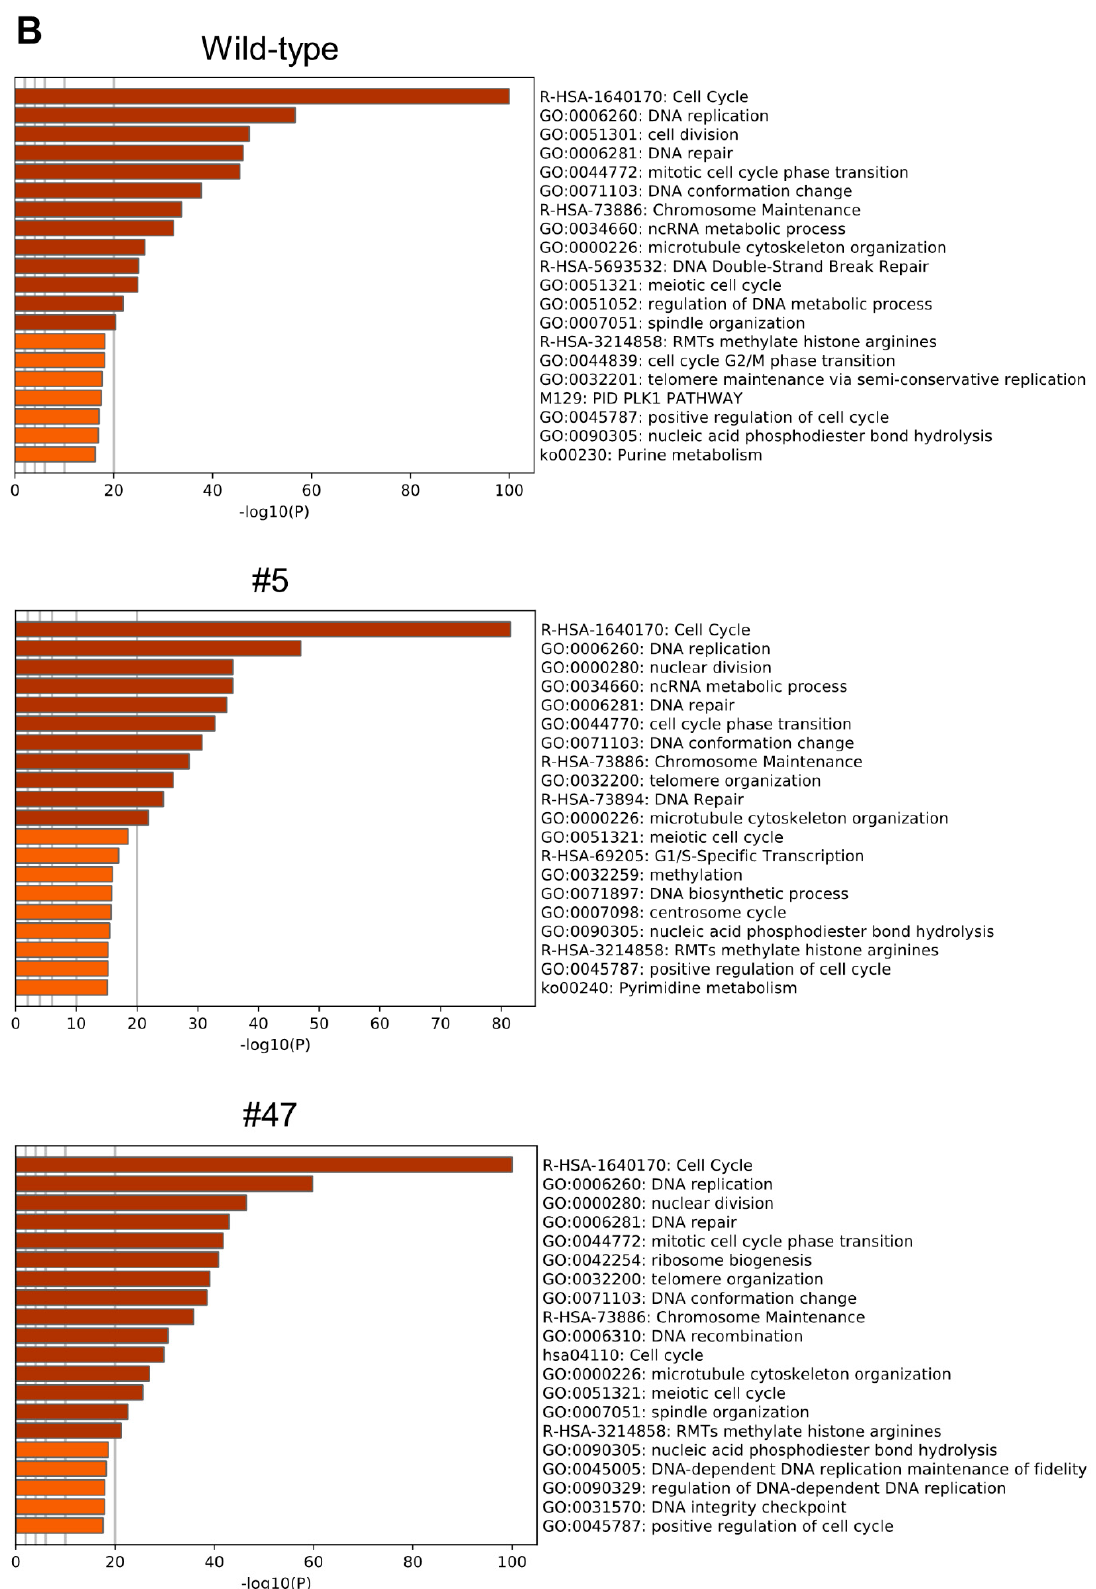
Figure 5. Gene Ontology (GO) analyses of microarray data ( A ) Analysis of the highly expressed genes on day 4 compared with day 0. Twenty gene groups of GO with lowest p -values are shown. ( B ) Analysis of the genes whose expression was low on day 4 compared with day 0. Twenty gene groups of GO with the lowest p -values are